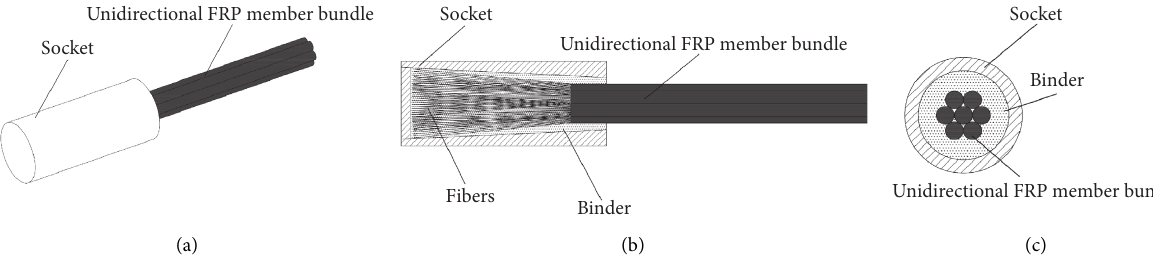
Figure 5: Diagram of dissolution-rebond anchor of a unidirectional FRP member bundle. (a) Elevation. (b) Profile. (c) Cross